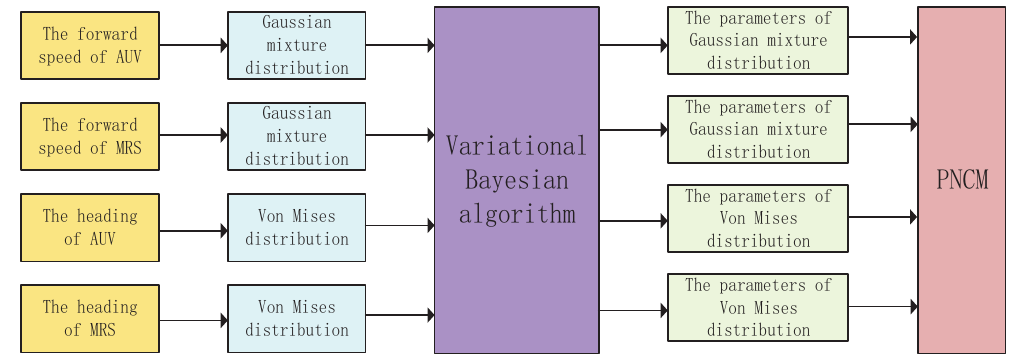
Figure 5. The framework of PNCM estimation